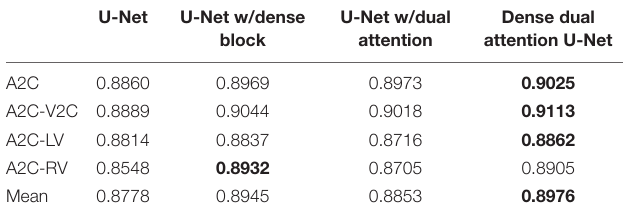
TABLE 5 | Performance of U-Net with different modules.